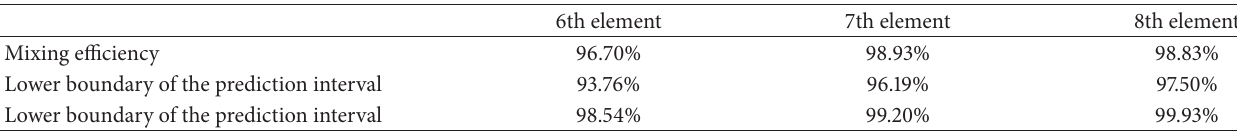
Table 4: Prediction intervals for the mixing efficiency coefficients computed along transversal cross sections at the outlet channels of the final three tesla elements of the passive